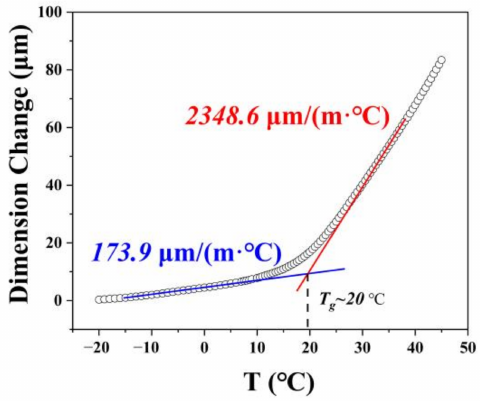
Figure 4. The relationship between dimension change and temperature of PBMA, and the CTEs of PBMA in glass state and high elastic state are calculated,